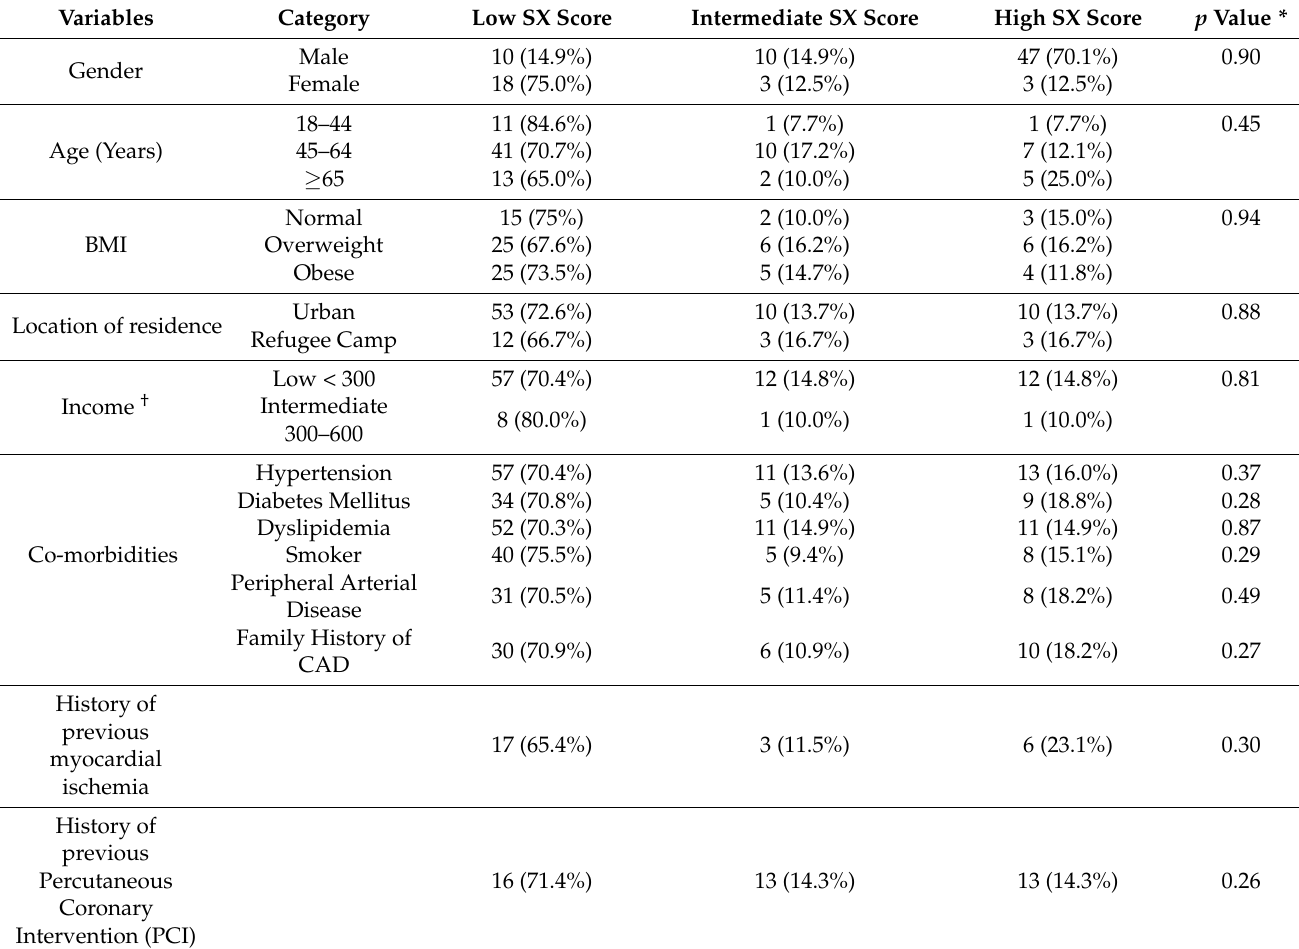
Table 1. Demographic profile and clinical characteristics of the study population.